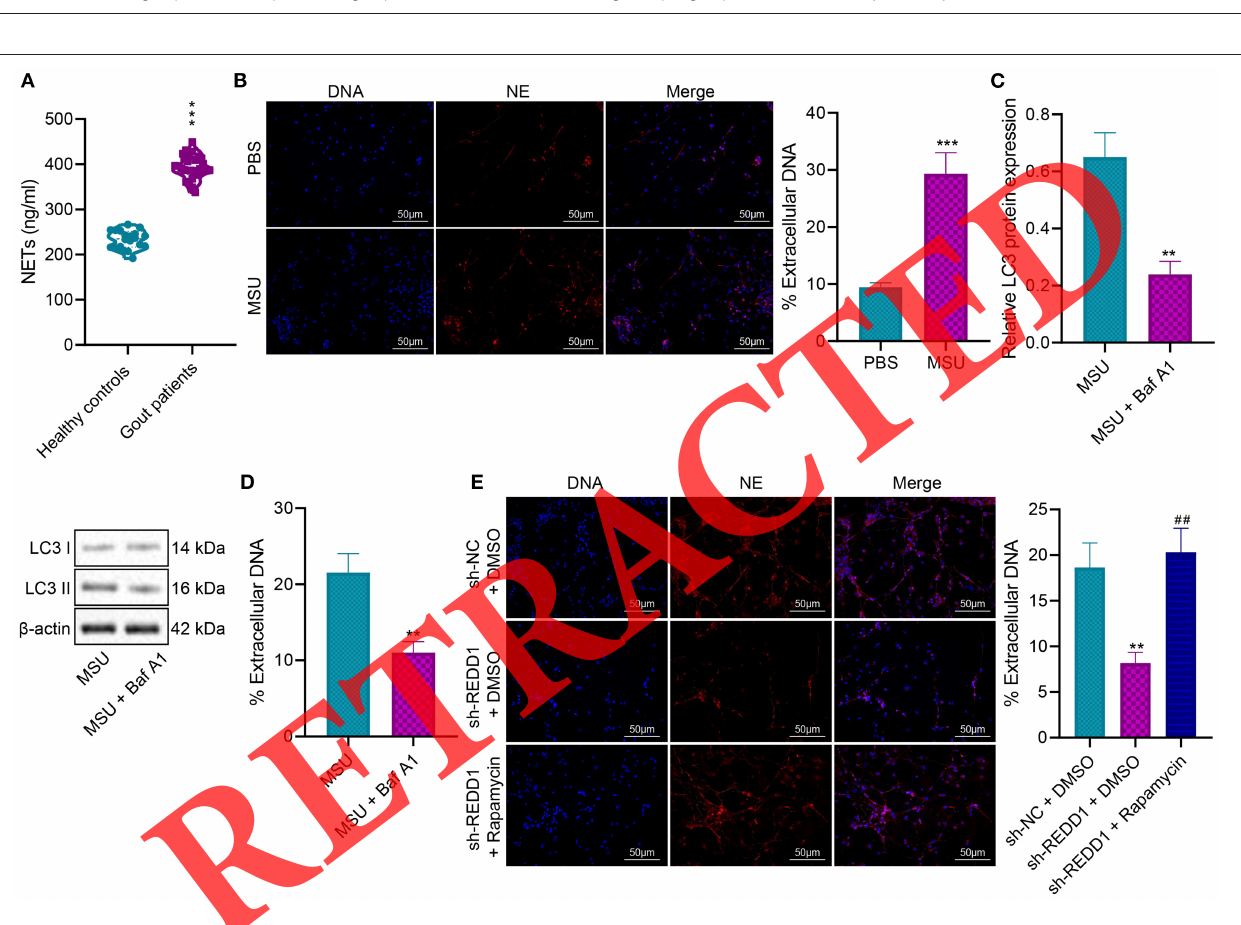
FIGURE 3 | analysis of REDD1-related genes. The abscissa represents GeneRatio, the ordinate represents the entry identifier, the color represents enrichment p -value, and the size represents the number of enriched genes in the identifier. (C) Western blot analysis of p-S6 and p-4EBP in the peripheral blood neutrophils of 28 gout patients and 20 healthy controls. (D) Levels of IL-17, IL-23 and IL-1 β in the peripheral blood of 28 gout patients and 20 healthy controls measured by ELISA. (E) Western blot analysis of p-S6 and p-4EBP in the MSU-treated neutrophils. (F) Levels of IL-17, IL-23 and IL-1 β in the MSU-treated cell supernatant measured by ELISA. (G) mRNA expression of REDD1 determined by RT-qPCR in neutrophils treated with sh-REDD1. (H) Western blot analysis of p-S6, p-4EBP and LC3 II in neutrophils treated with sh-REDD1. (I) mRNA expression of REDD1 determined by RT-qPCR in neutrophils treated with sh-REDD1 or combined with Rapamycin. (J) Western blot analysis of p-S6, p-4EBP and LC3 II in neutrophils treated with sh-REDD1 or combined with Rapamycin. (K) Levels of IL-17, IL-23 and IL-1 β in the supernatant of cells treated with sh-REDD1 or combined with Rapamycin measured by ELISA. In (C,D) , *** p < 0.001, compared to healthy controls. In (E,F) , ** p < 0.01, compared to cells treated with PBS; *** p < 0.001, compared to cells treated with PBS. In (G,H) , ** p < 0.01, compared to cells treated with sh-NC; *** p < 0.001, compared to cells treated with sh-NC. In (I–K) , ** p < 0.01, compared to cells treated with sh-NC + DMSO; ## p < 0.01, compared to cells treated with